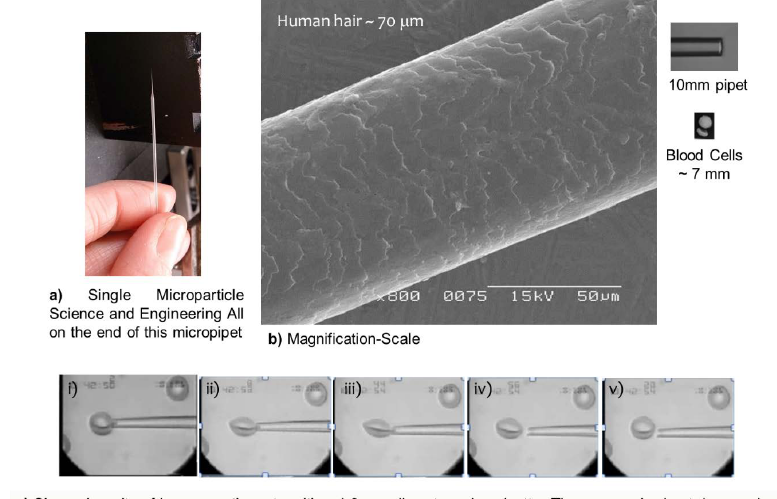
Figure 1. Micropipette and scale. ( a ) Photograph of an actual micropipette held by hand; ( b ) Magnification and scale comparing the diameter of a human hair of ~70 µ m, to scale with the tip of a typical micropipette of 10 µ m that is routinely used for manipulation of emulsion microdroplets and microparticles. Also shown are a neutrophil and erythrocyte that are ~7 µ m in diameter; ( c ) A 1.2 µ m diameter micropipette as used in the experimental measures and mechanical analyses of the shear viscosity of a single erythrocyte, and the experiment that takes about 1 s: (i) initial aspiration of the discoid erythrocyte membrane that was point attached to the glass cover slip; (ii) movement of the micropipette back extends the cell in shear; (iii) full extension; (iv) release of the cell and observation of its elastic recoil against its shear viscosity; (v) cell returns to its discoid shape (see Video S1 in Supplementary